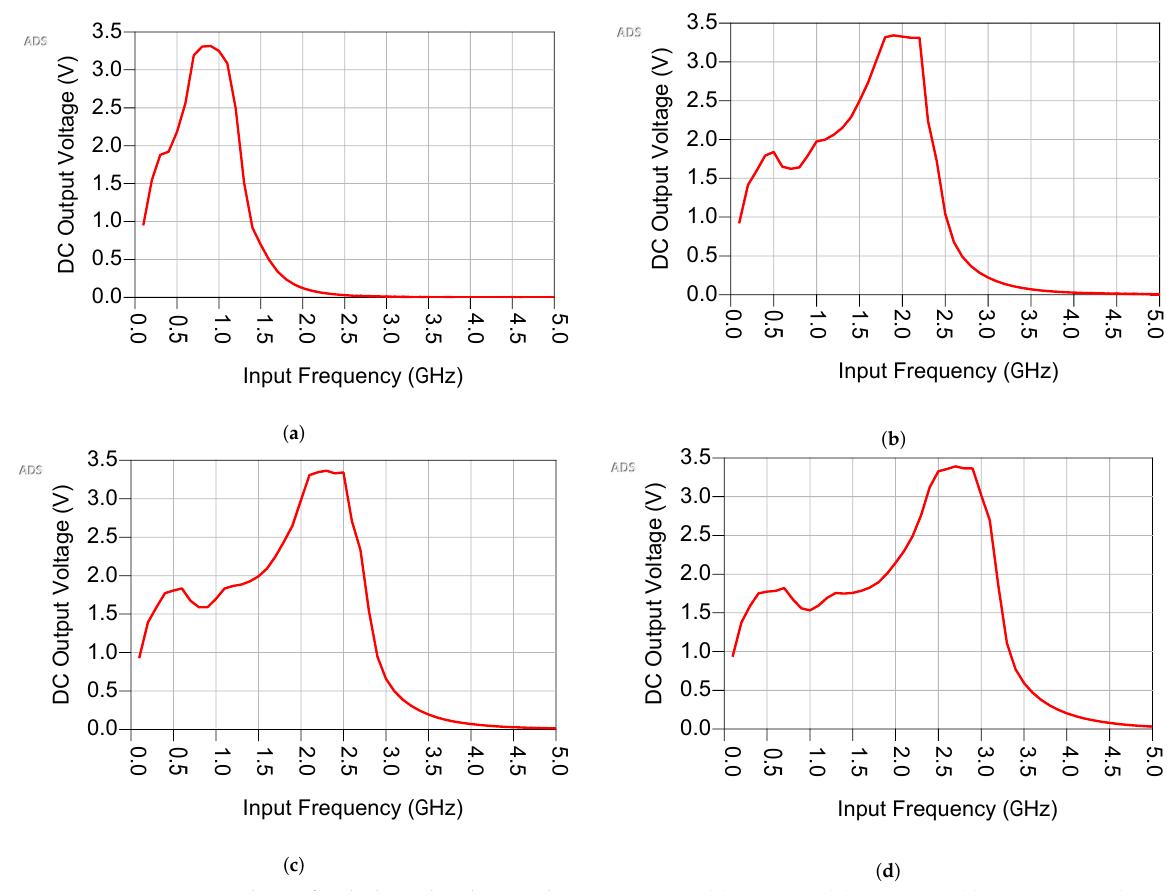
Figure 19. Output voltage of each channel under + 10 dBm input power. ( a ) GSM-900. ( b ) GSM-1800. ( c ) UMTS-2100. ( d ) Wi-Fi 2.45.